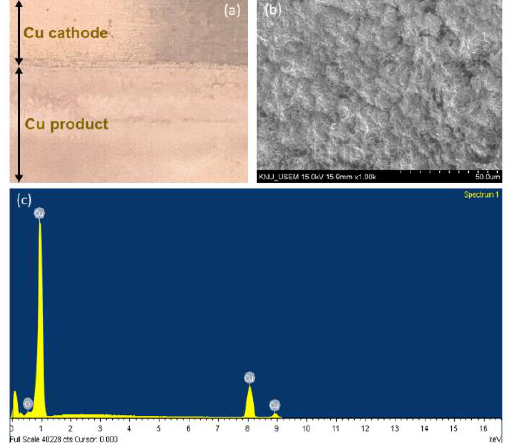
Figure 10. The deposited Cu product on the cathode at optimal conditions. ( a ) Images of deposited Cu layer on the cathode; ( b , c ) SEM-EDS images of the deposited Cu Table 2. Comparison of current efficiency and energy consumption of Cu electrodeposition from different resources and